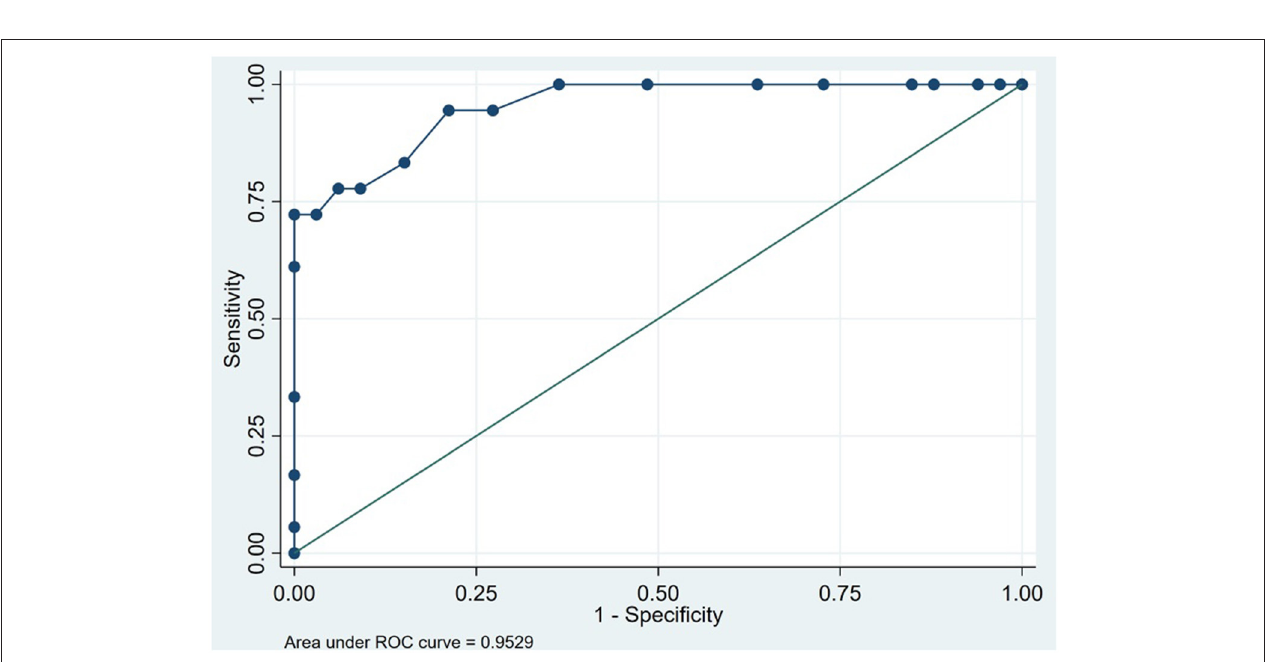
FIGURE 4 | Receiver operating characteristic curve for revised-Self Monitoring Scale in 51 patients to discriminate between behavioral variant frontotemporal dementia and Alzheimer’s disease (Instituto Peruano de Neurociencias, Lima, Peru; 2017–2020).